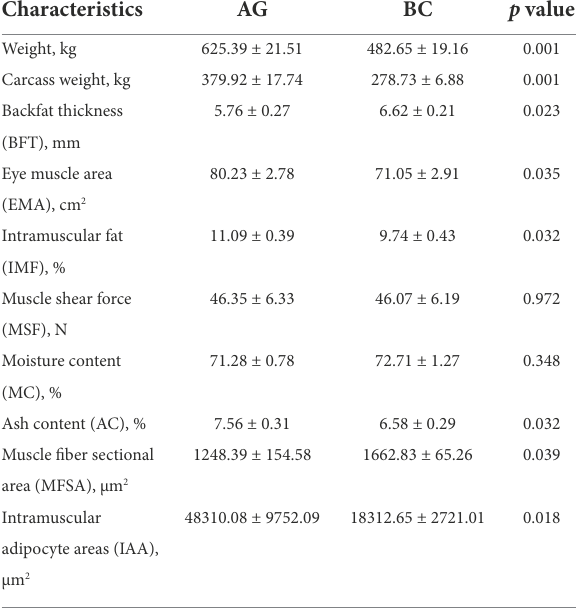
TABLE 2 Comparison of beef quality